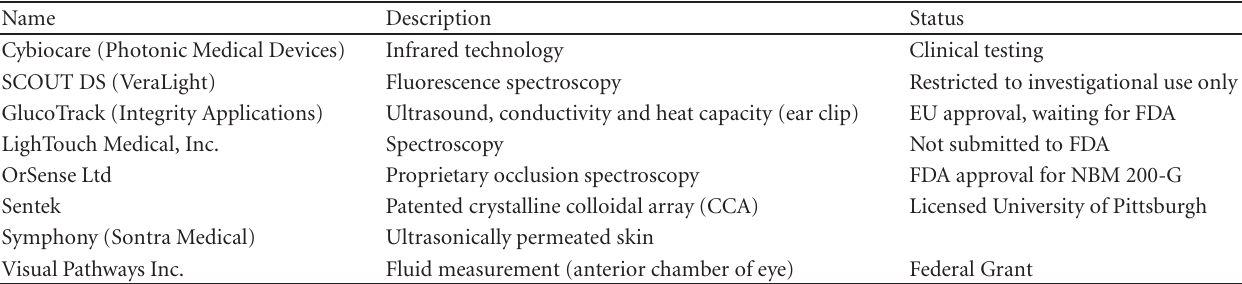
Table 2: Noninvasive